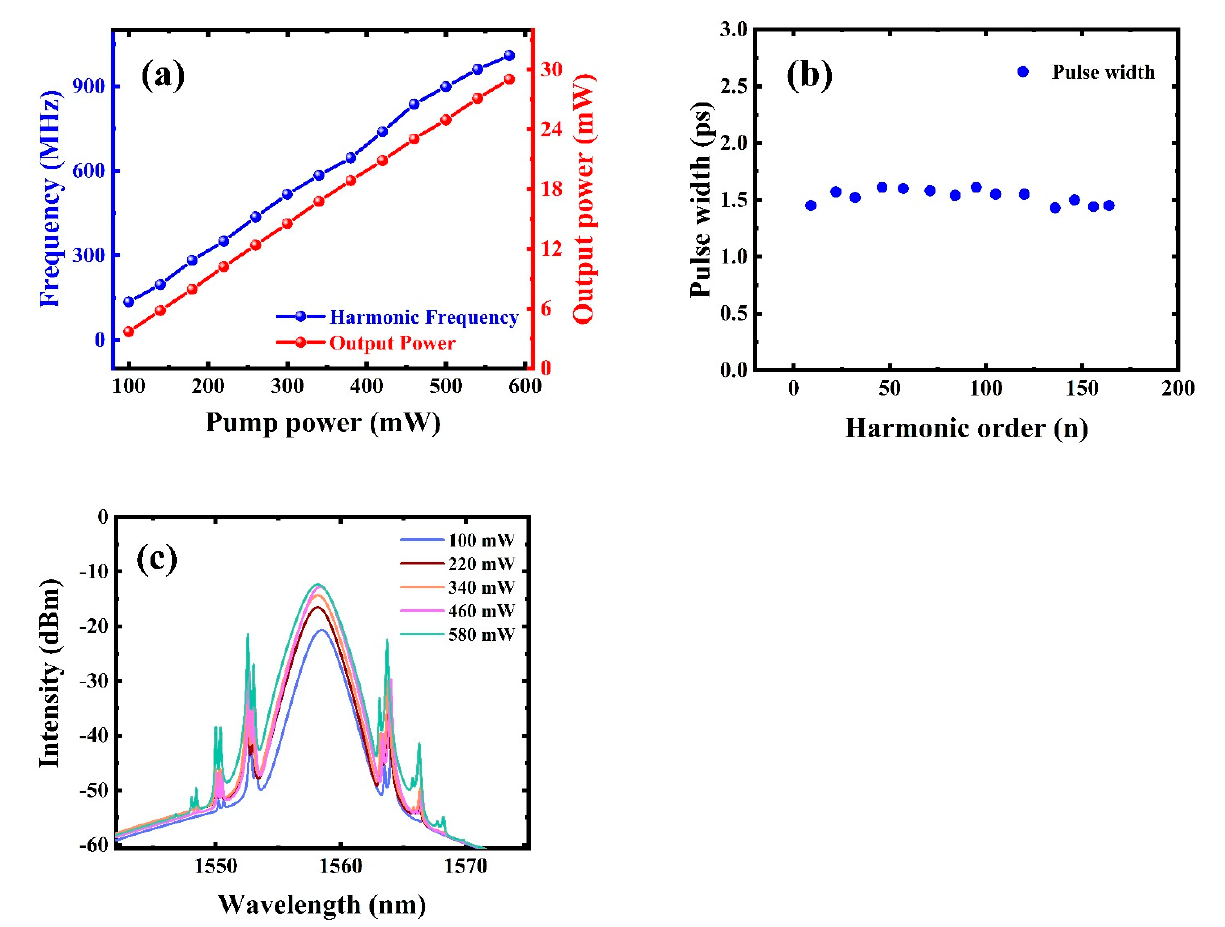
Figure 7. ( a ) Repetition rates and output powers at different pump powers. ( b ) Pulse widths under different orders. ( c ) Optical spectral properties at different pump powers.